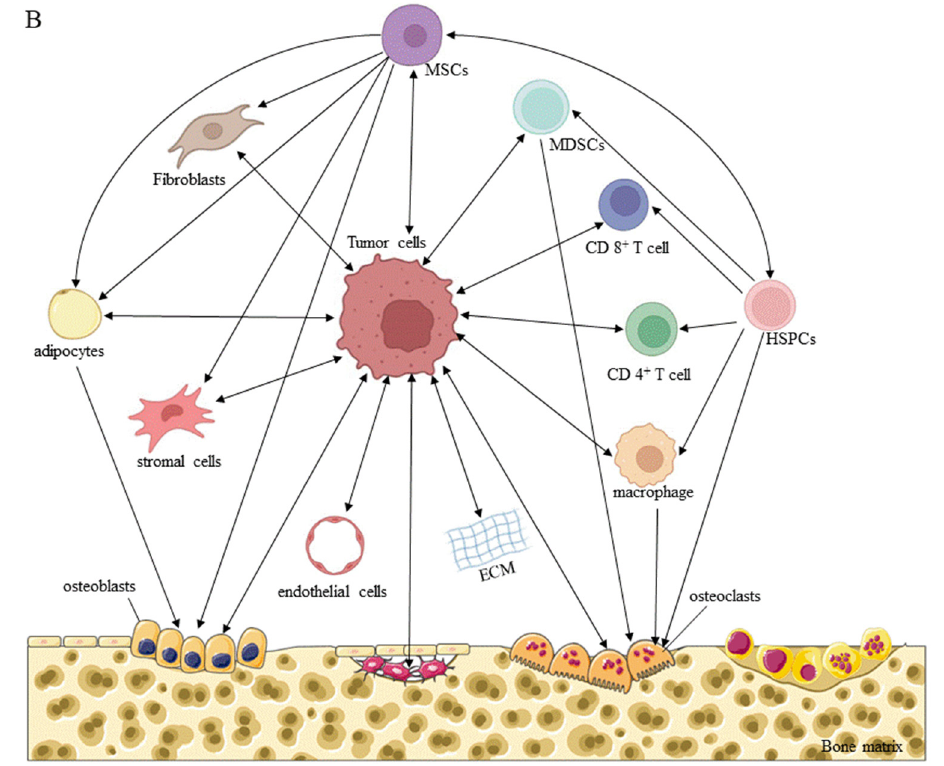
Figure 3. Interactions of tumor cells with the bone microenvironment. ( A ). Tumor cells in the bone microenvironment secrete tumor-related factors to act on osteoblasts, and the interaction of RANKL produced by osteoblasts with RANK expressed on osteoclasts stimulates osteoclast maturation and differentiation, leading to metastatic bone destruction. Bone resorption results in the release of var- ious growth factors, such as TGF −β , IGFs, FGFs, PDGF, and BMPs, as well as Ca 2+ , which